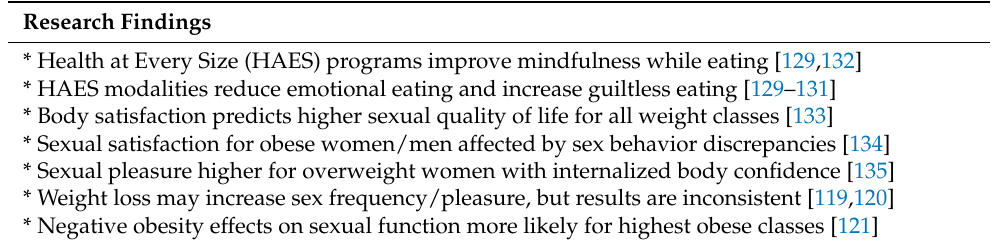
Table 5. Intersection of overweight/obesity, body image/positivity constructs, and sexuality. Research